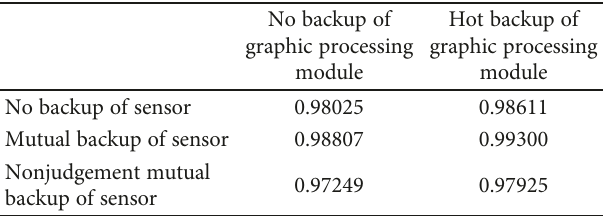
Table 3: Availability for di ff erent architectures of basic display function under the steady states.